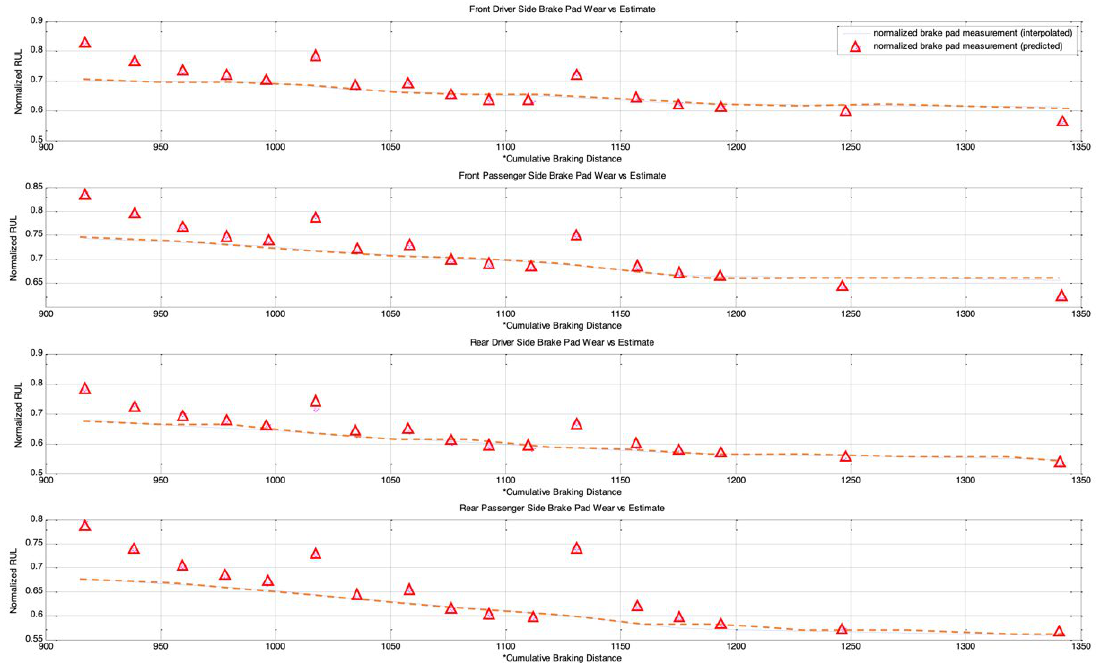
Figure 20. Driver #2, inferred normalized brake wear (dashed-line) vs. predicted brake wear (triangle). Top–bottom shows front driver side, front passenger side, rear driver side, and rear passenger side.